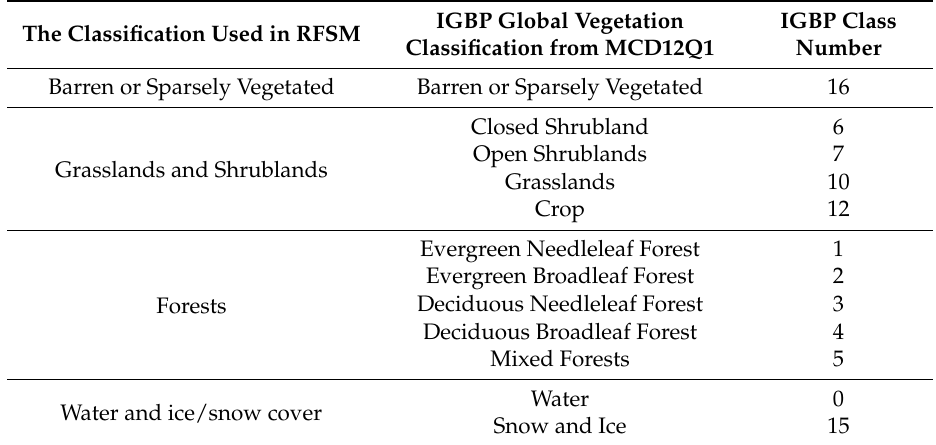
Table 2. Classification used in random forest (RF)-based on International Geosphere-Biospheres Programme (IGBP) global vegetation classification. The Classification Used in